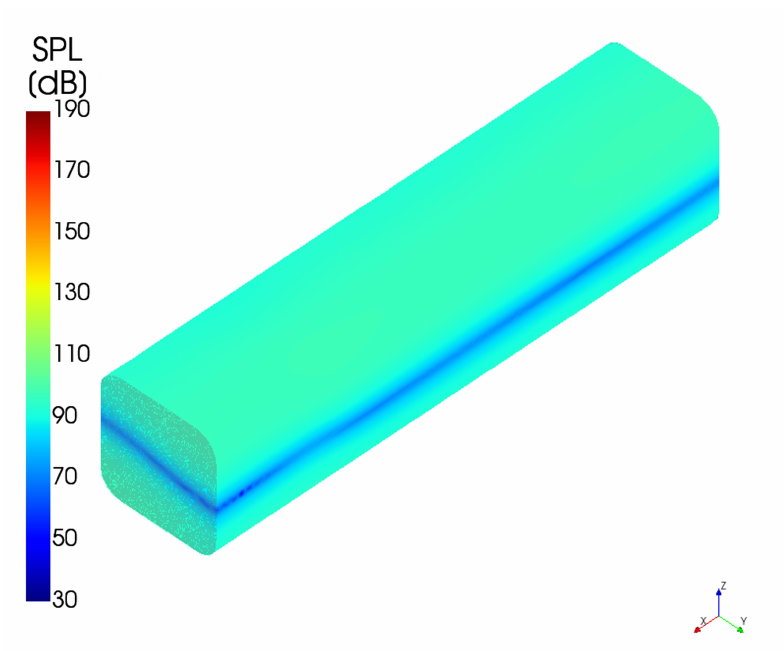
Figure 30. Sound pressure at the cavitation tunnel walls at approximately 1300 Hz—VOF solution.